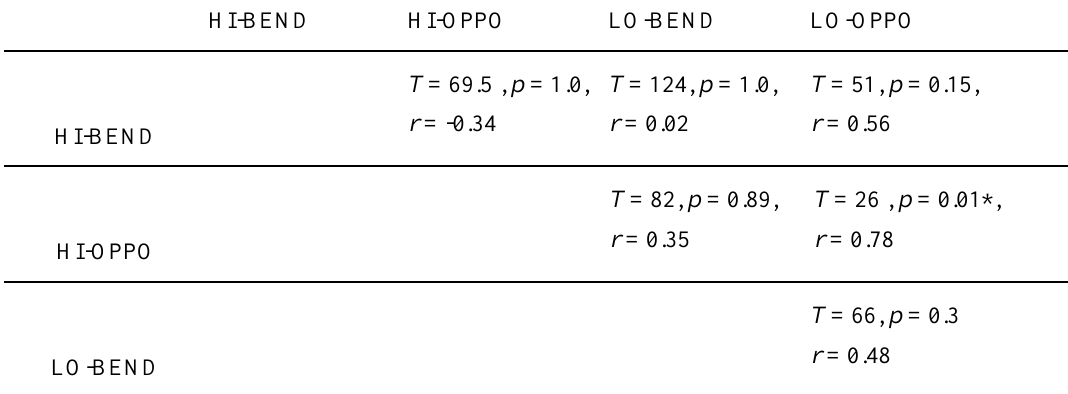
Table 3. Pairwise comparisons of the hit rates for different target positions while driving on a straight. HI-BEND HI-OPPO LO-BEND LO-OPPO T = 69.5 , p = 1.0, T = 124, p = 1.0, T = 51, p = 0.15, r = -0.34 r = 0.02 r = 0.56 HI-BEND T = 82, p = 0.89, T = 26 , p = 0.01*, r = 0.35 r = 0.78 HI-OPPO T = 66, p = 0.3 r = 0.48 LO-BEND